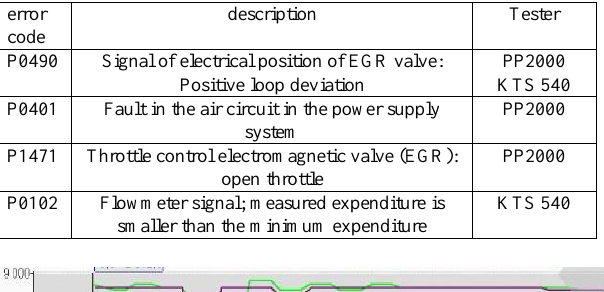
Table 1. Record of error codes during the test under stationary conditions and traction test